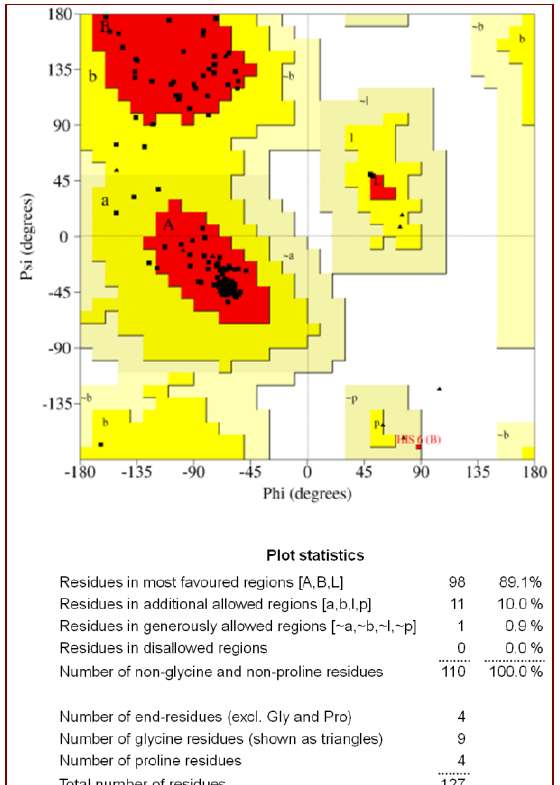
Figure 1. A Ramachandran plot of the main chain torsion angles (φ,ψ) for the final refined model. The plot was calculated with the program PROCHECK [25]; non-glycine residues are identified by squares.